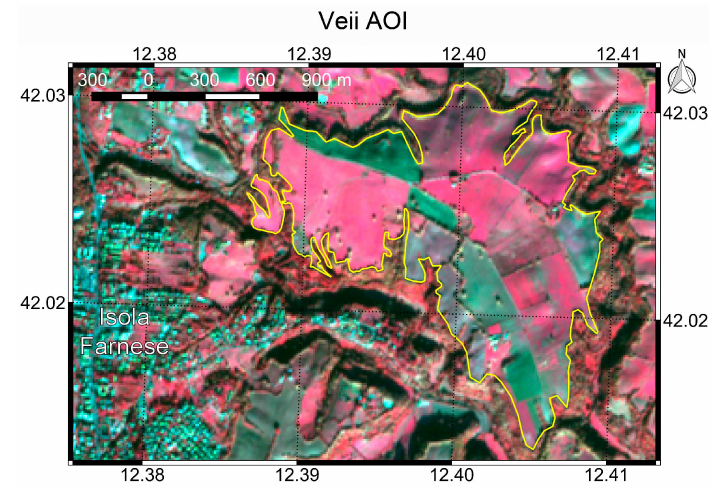
Figure 53. Sentinel-2 image of the Veii AOI (shown in yellow polygon), acquired on 28 December 2015. 10 m spatial resolution. Displayed as band 8 (NIR), band 4 (R) and band 3 (G) respectively as R, G and B. Pleiades data provided by the European Space